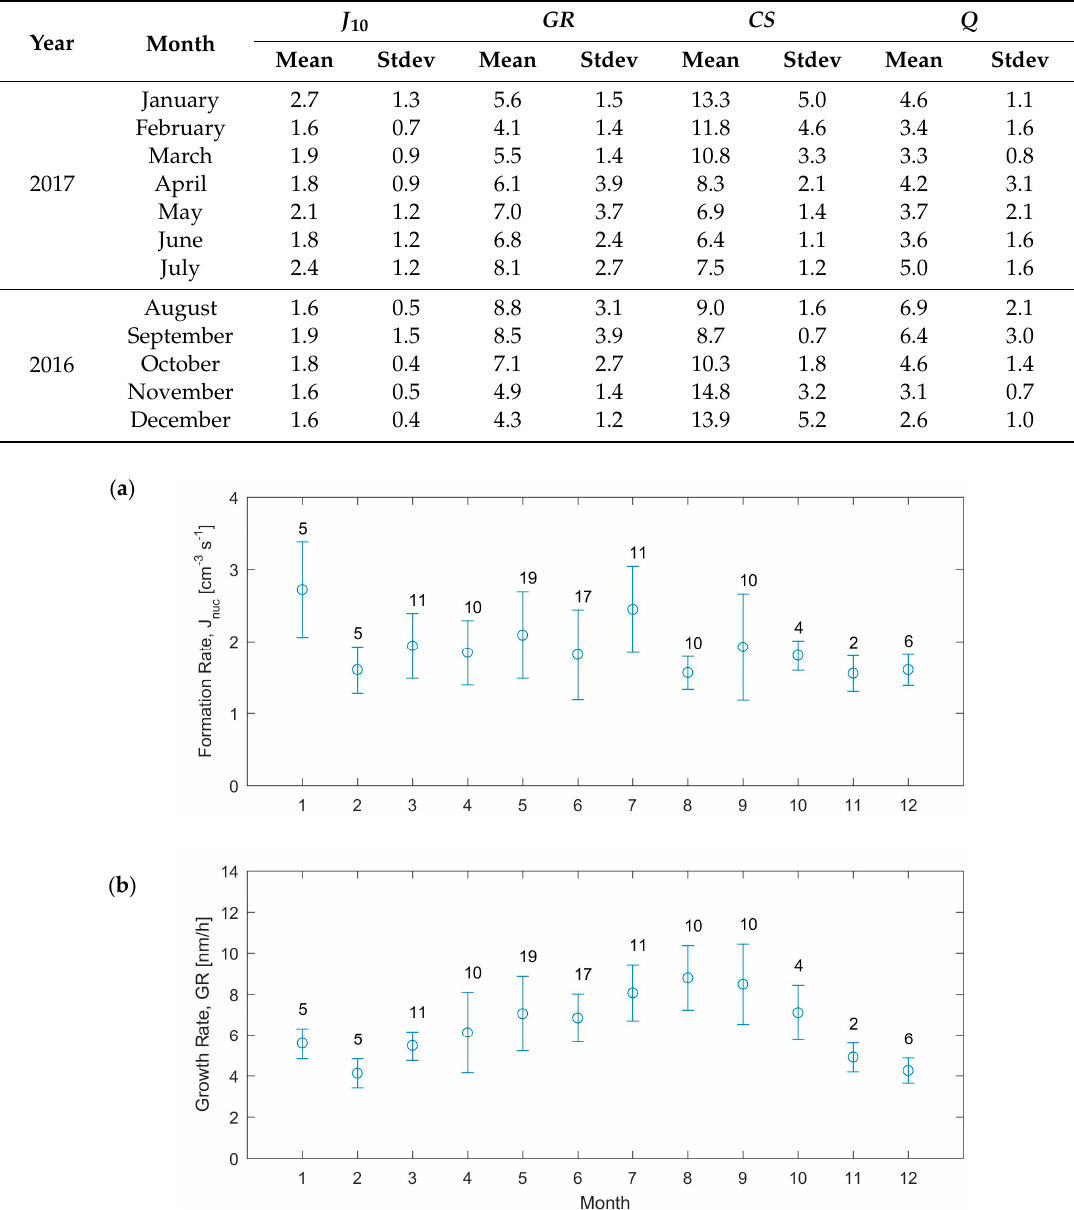
Figure 5. Yearly pattern of the ( a ) observed formation rate ( J 10 ) and ( b ) modal growth rate during NPF events. The bars represent the standard deviation and the number above represents the number of observations during that month.